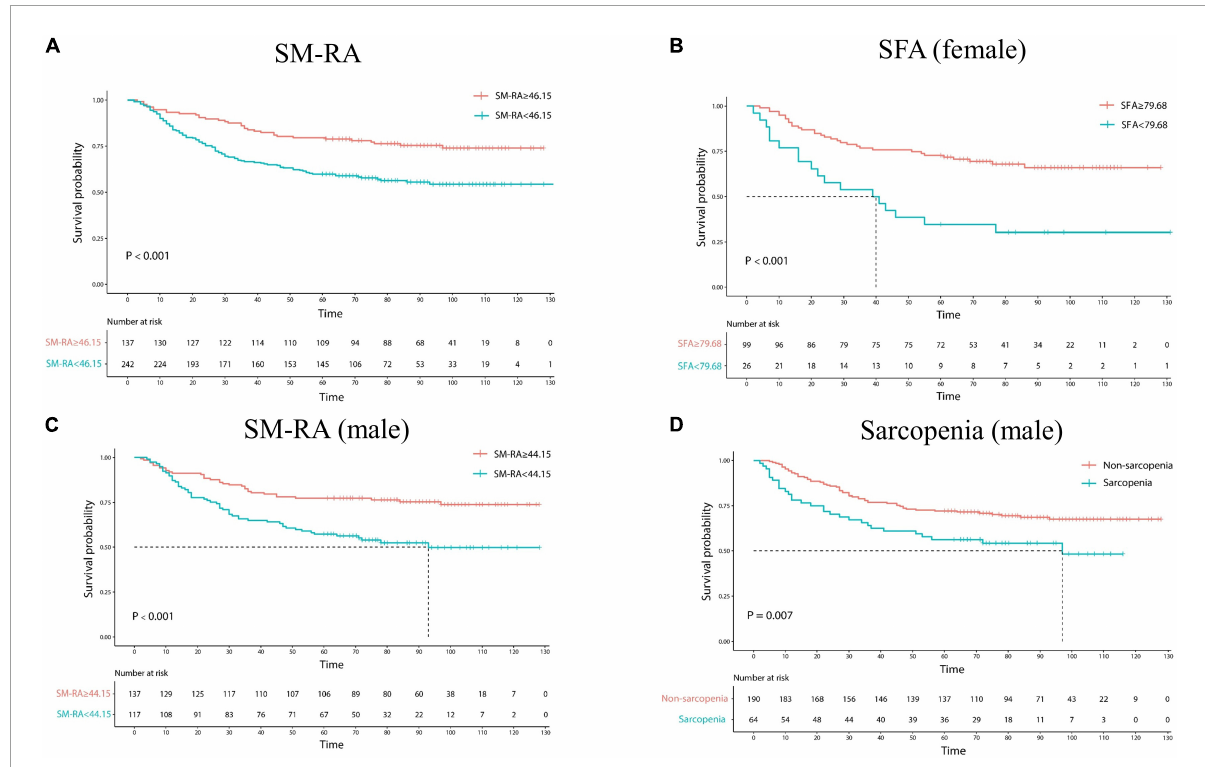
FIGURE4 Kaplan–Meier estimates of overall survival in patients with gastric cancer according to SM-RA (A) , SFA status for female (B) , SM-RA for male (C) , and CT-determined sarcopenia for male (D) . SFA, subcutaneous fat area; SM-RA, skeletal muscle radiation